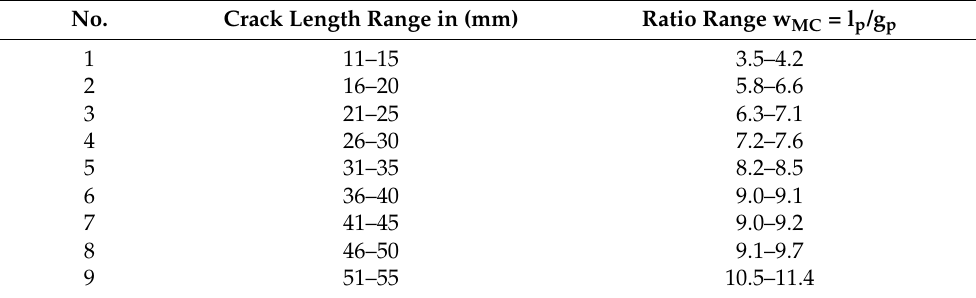
Table 3. Ranges of w MC coefficients for different ranges of surface crack